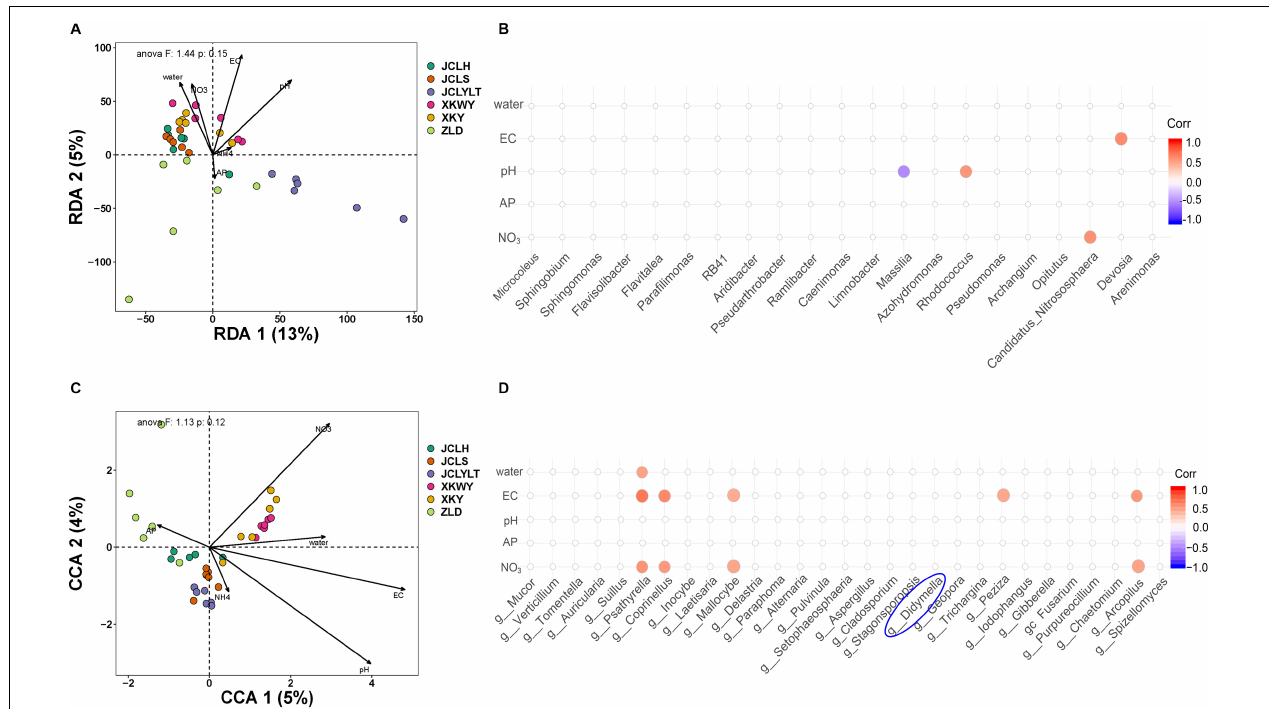
FIGURE 1 | The influence degree of soil properties to the (A) bacterial community, (C) fungal community, and corresponding correlations between soil properties and (B) bacteria and (D)